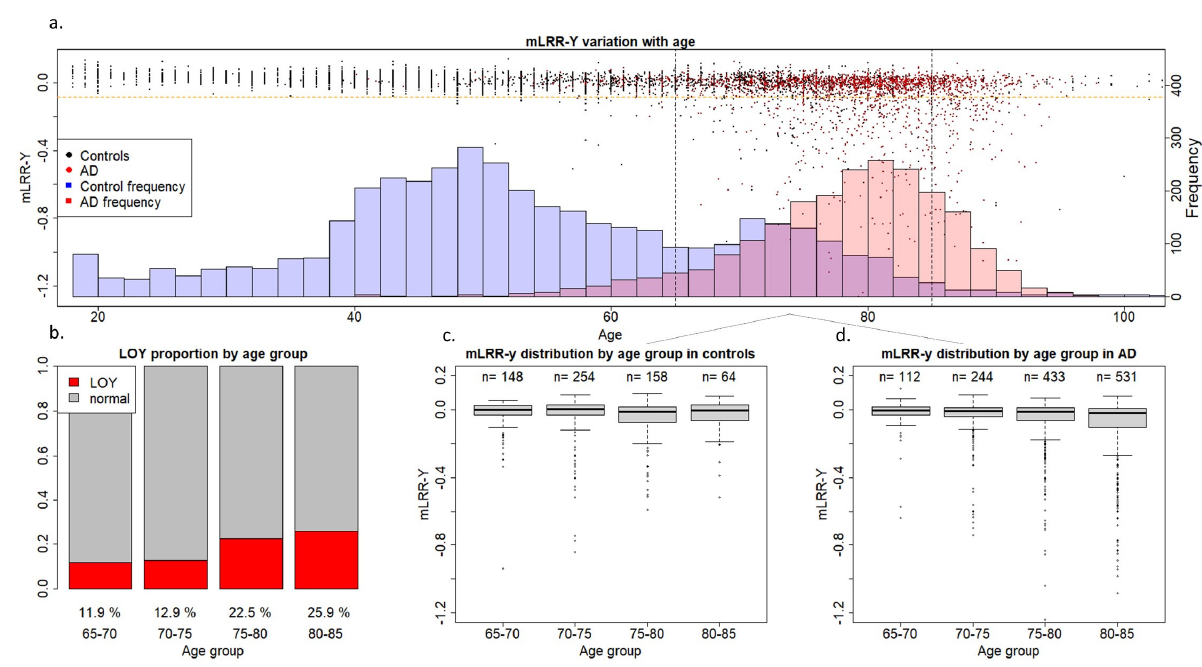
Figure 1. mLRR-y variation with age in the GR@ACE-DEGESCO cohort. ( a ) Age and mLRR-Y distribution in the case and control groups. The dots represent mLRR-Y values for individual samples, and the histogram represents the age distribution across the case and control groups. ( b ) Proportion of individuals with mLOY in the different age groups based on age at blood sampling. ( c , d ) mLRR-Y distribution for the different age groups based on age at blood sampling in control and AD individuals, respectively.